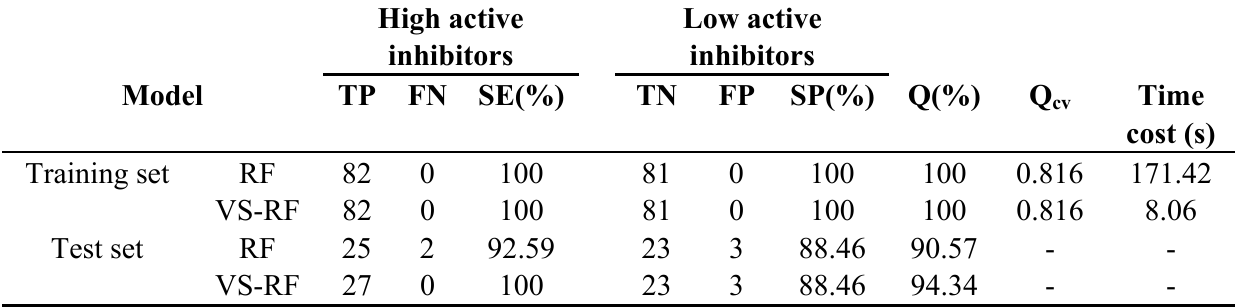
Table 3. Comparison of random forest (RF) statistical performance with and without variable selection based on the respiratory syncytial virus (RSV) inhibitor dataset a